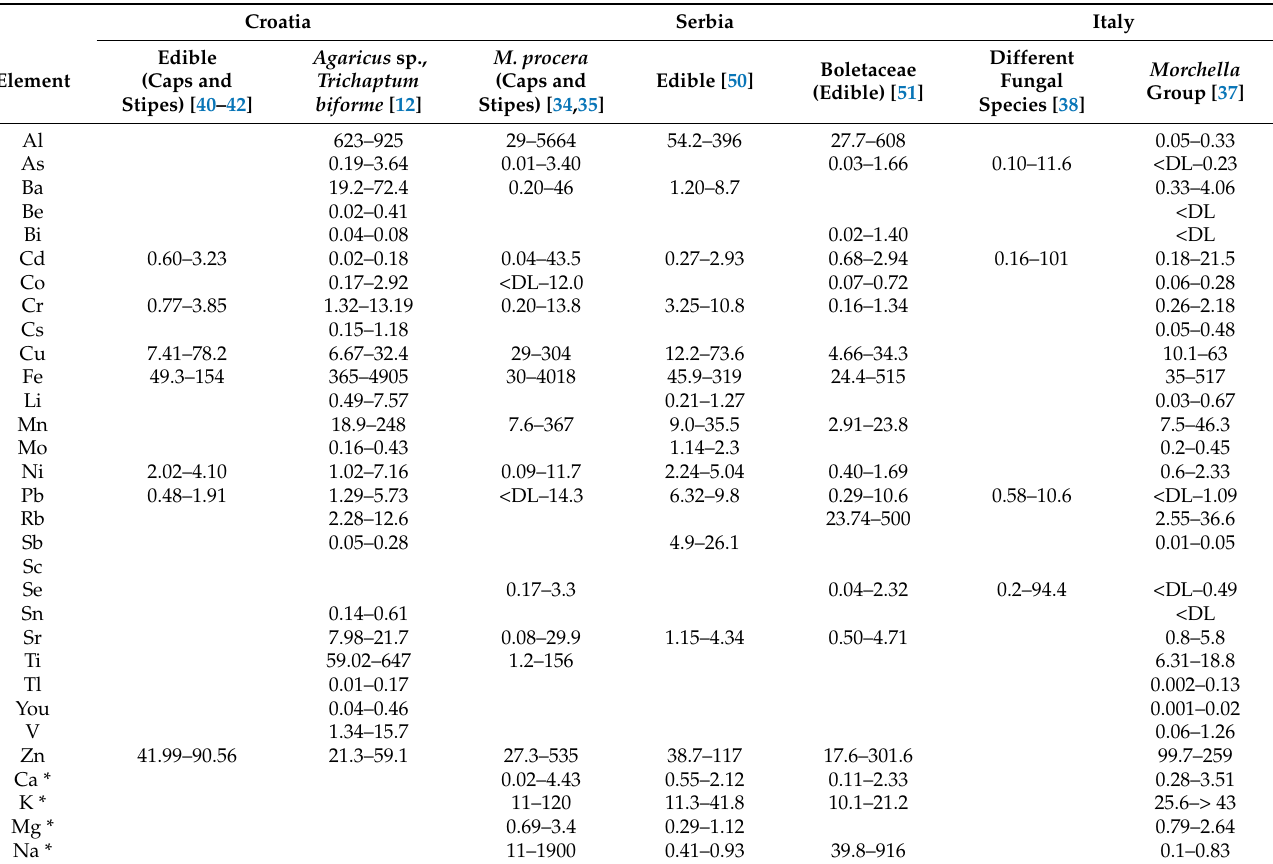
Table 4. Concentration of macro- and trace elements in different mushrooms from the region (expressed in mg/kg or * g/kg). If not otherwise specified, the results refer to the fruiting